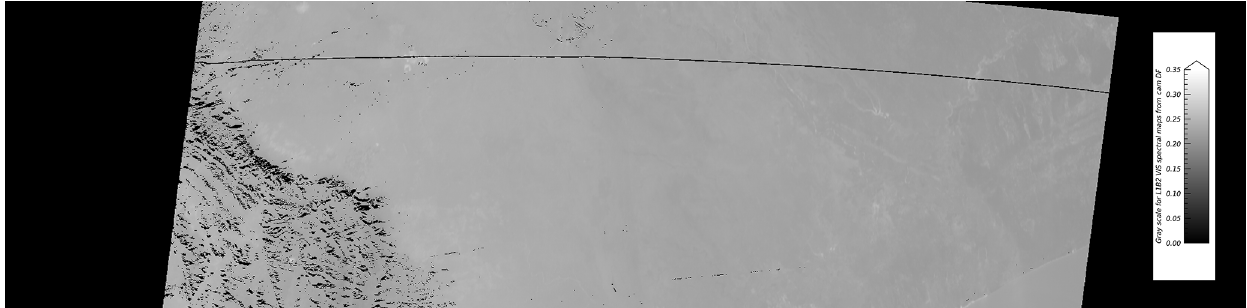
Figure 1. Example of missing lines (in this case two consecutive lines) in the L1B2 terrain-projected L OCAL M ODE bidirectional reflectance factor data for the blue spectral band of the DF camera for P ATH 168, O RBIT 68050 and B LOCK 110, covering an area located in eastern South Africa. The linear gray scale, shown on the right side of the frame, assigns Brf values of 0 to black and Brf values of 0.35 or higher to white. The black spots on the western side of the map are due to pixels that are not observed at this slanted view angle due to the local topography. North is approximately towards the top of the image. The total size of the B LOCK area is 563.2km across-track (roughly west–east) by 140.8km along-track (roughly north–south), while the parallelogram-shaped ground area inside the B LOCK is about 380km